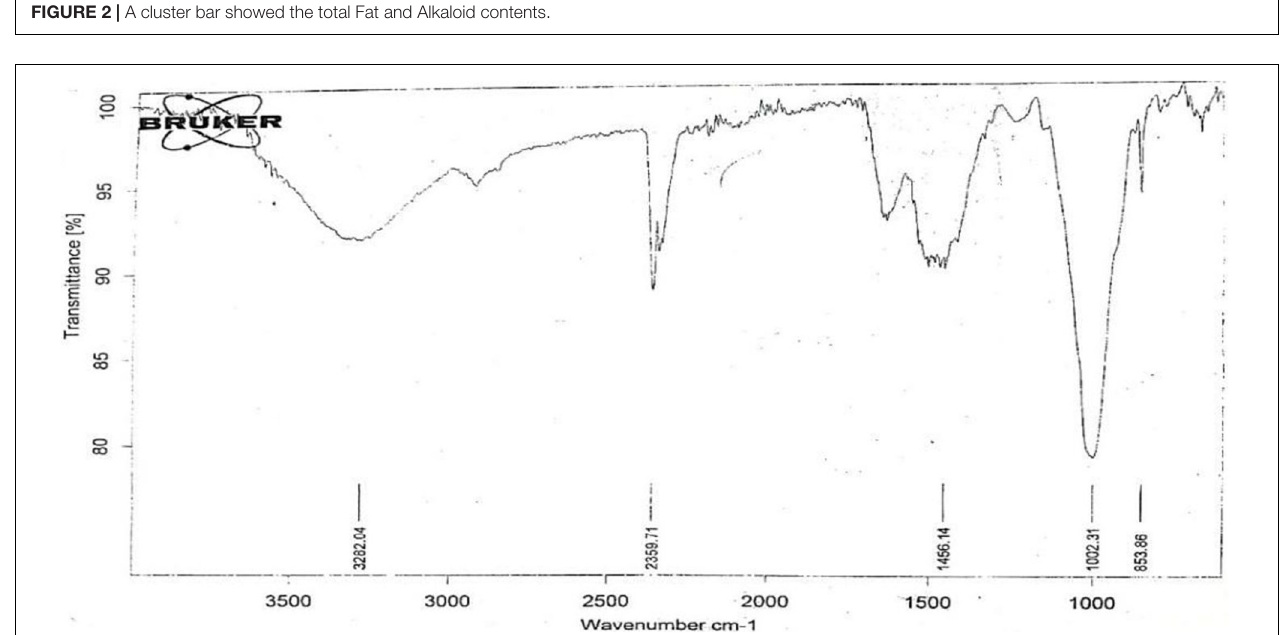
FIGURE 3 | Fourier Transform Infrared Analysis (FTIR) scan of Padina antillarum (Kützing) Piccone.